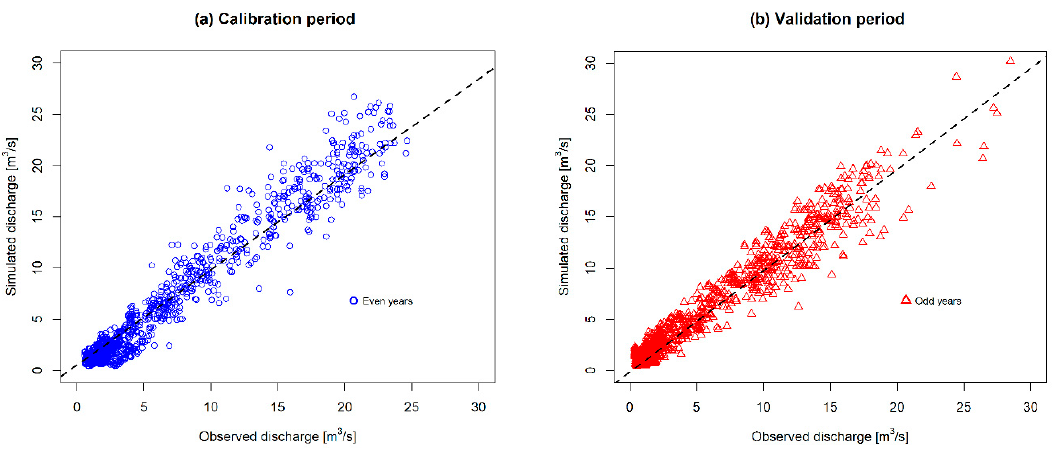
Figure 4. Comparison between observed and simulated values: ( a ) For the calibration period for even years; ( b ) For the validation period for odd years. The dashed line indicates the correlation trend. Table 4. Statistical efficiency indicator.